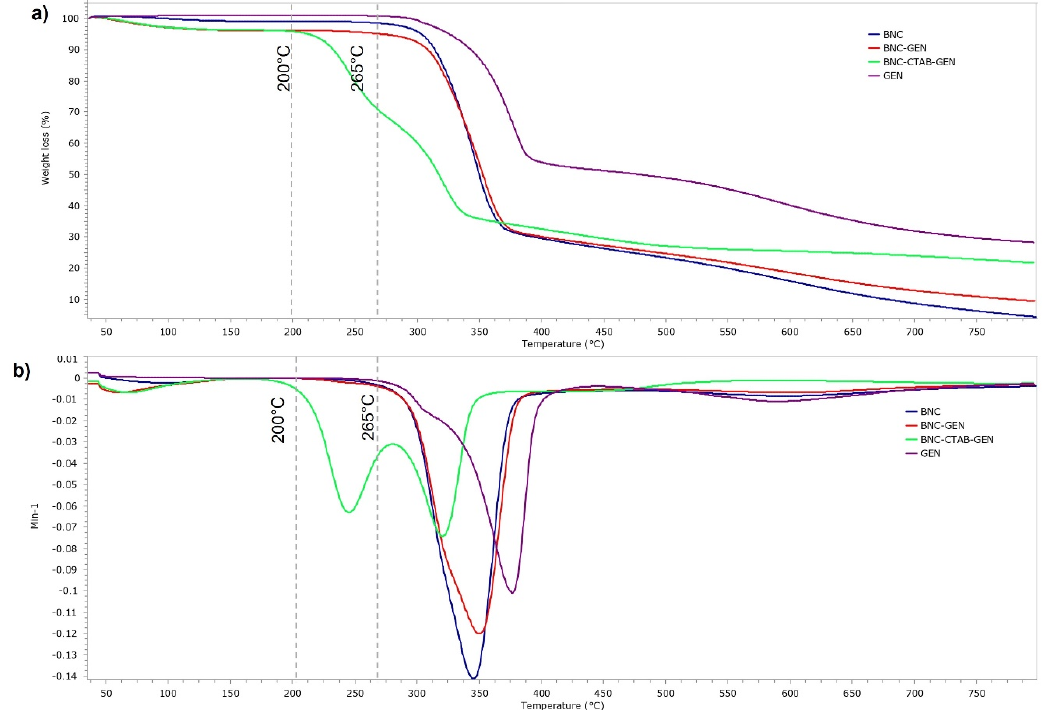
Figure 10 . Thermogravimetric analysis of BNC, GEN, BNC-GEN, and BNC-CTAB-GEN; ( a ) TGA thermogram; ( b ) DTG curves . thermogram; ( b ) DTG